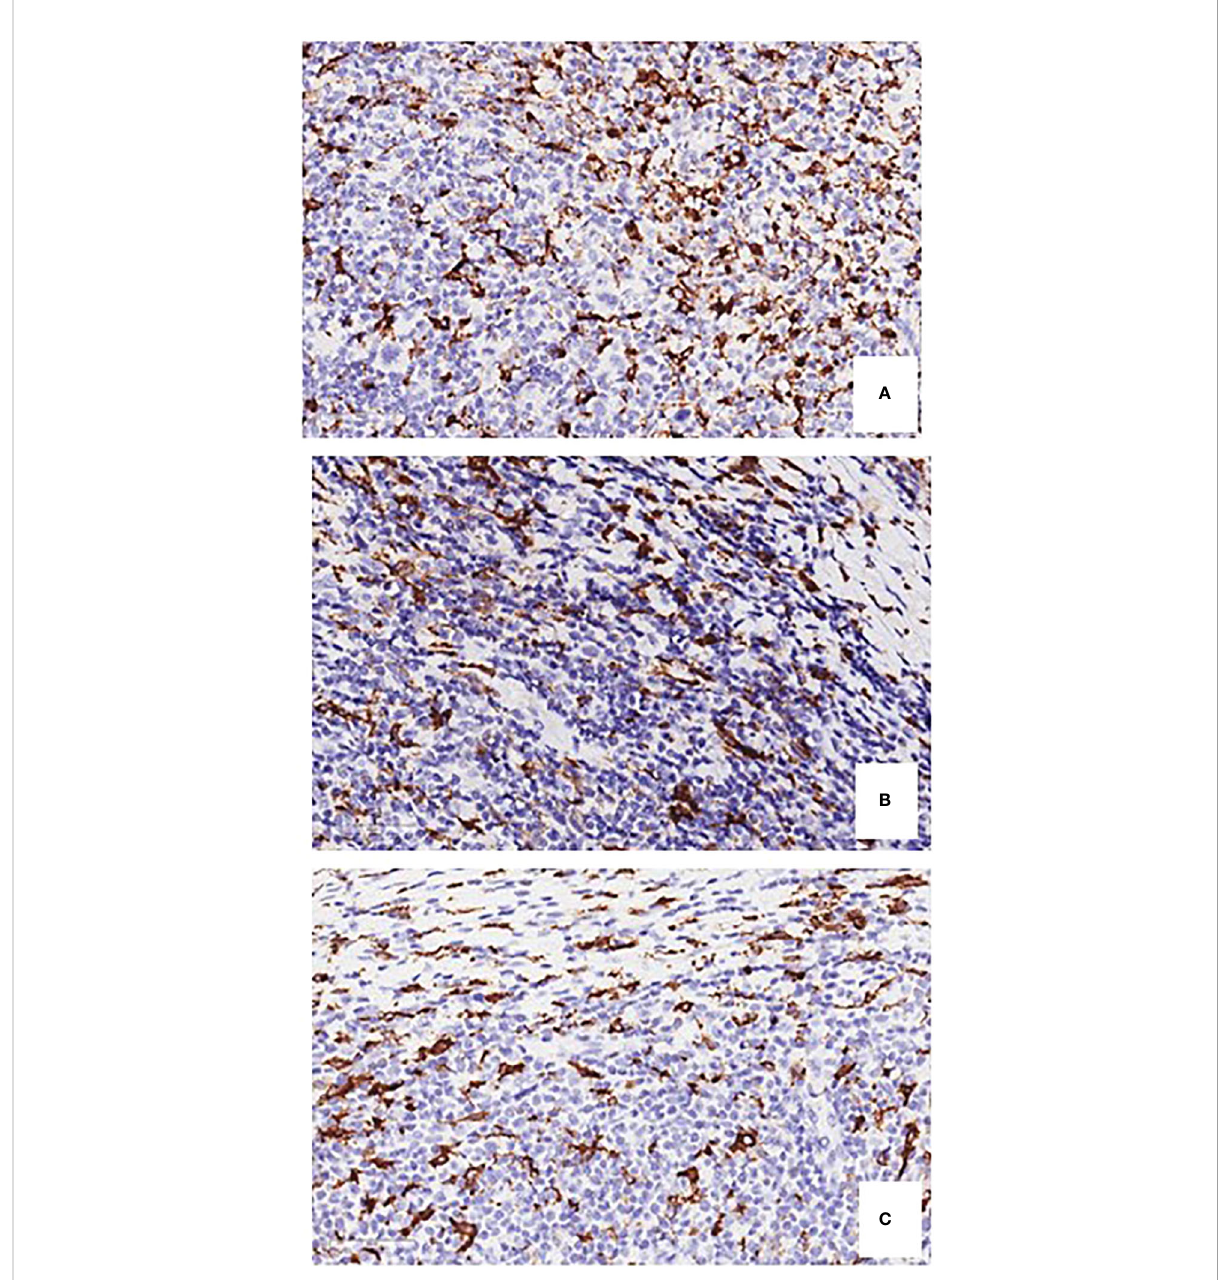
FIGURE 2 Immunostaining of CD163-positive and CD68-positive macrophages (A, B) , and tryptase-positive mast cells (C) , in bioptic specimens of human classical Hodgkin ’ s lymphoma. Original magni fi cation, 400